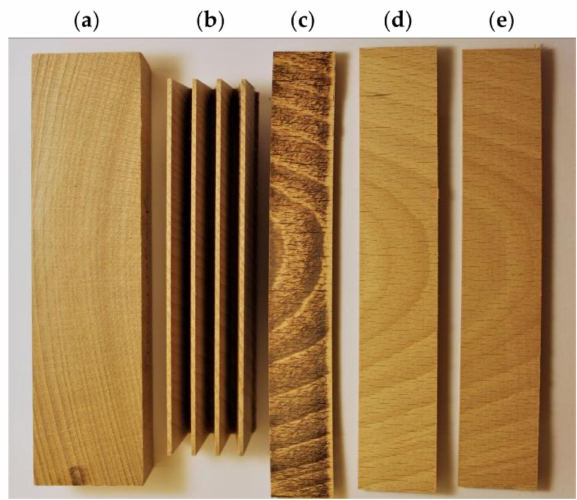
Figure 3. Surface processing of beech finger joints: ( a ) cross-section lamella; ( b ) horizontally cut finger joints; exemplary finger joints cut with ( c ) Cu1 (blunt) and F R 1 (4 m min − 1 ), ( d ) Cu2 (medium sharp) and F R 1 (4 m min − 1 ), ( e ) Cu3 (sharp) and F R 1 (4 m min − 1 ) for further surface evaluation.